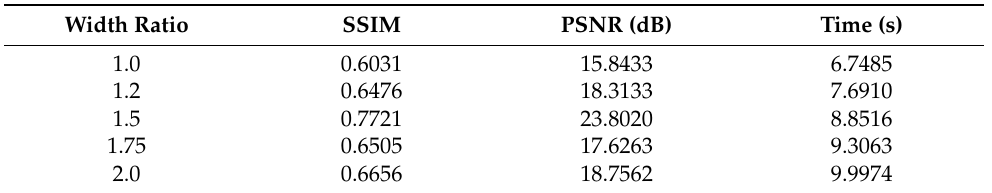
Table 4. Performances of proposed method according to size of neighboring blocks for indoor picture (Hallway) having a large